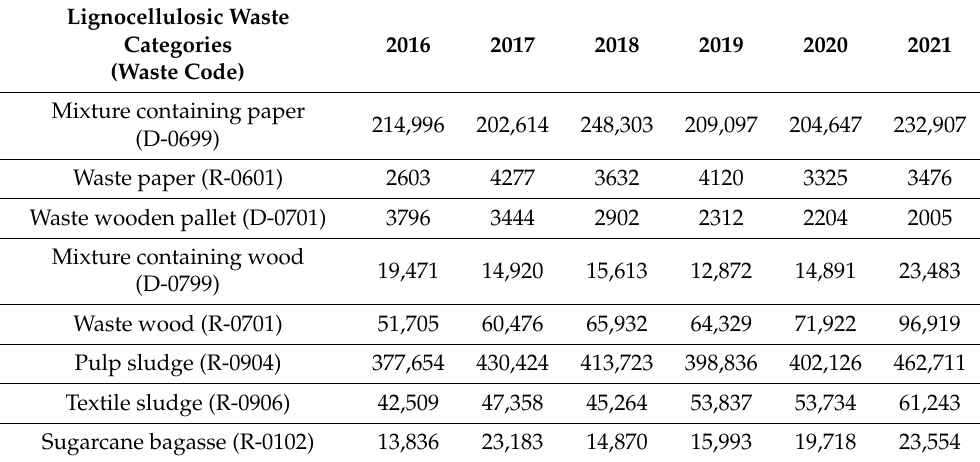
Table 3. Reported generation amounts of lignocellulosic waste categories used as feedstocks for producing SRFs in Taiwan a .